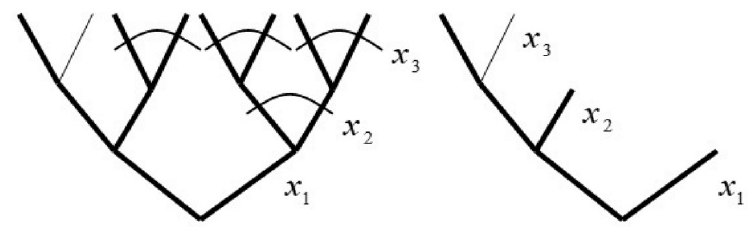
Figure 2. Logic tree and simplified logic tree.